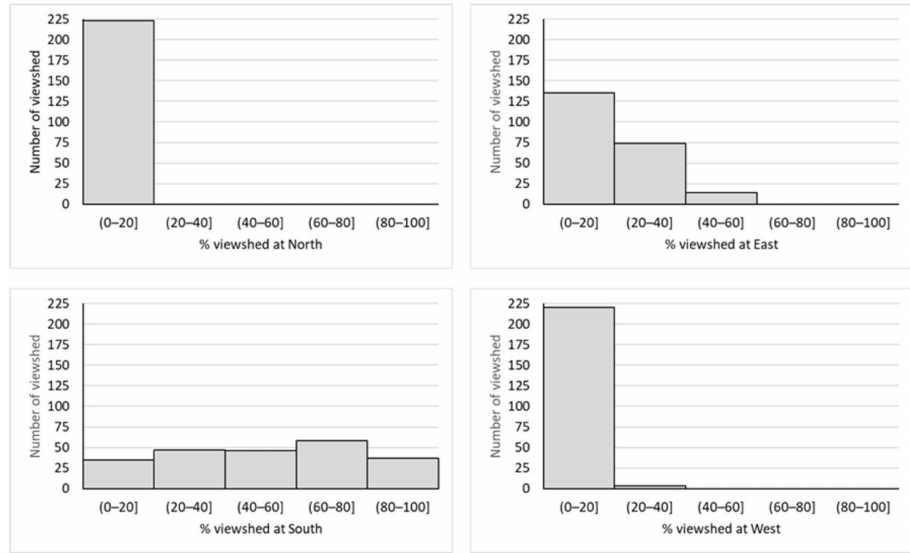
Figure 5. Percentage of visual basins emitted from dwellings according to their main orientation (own